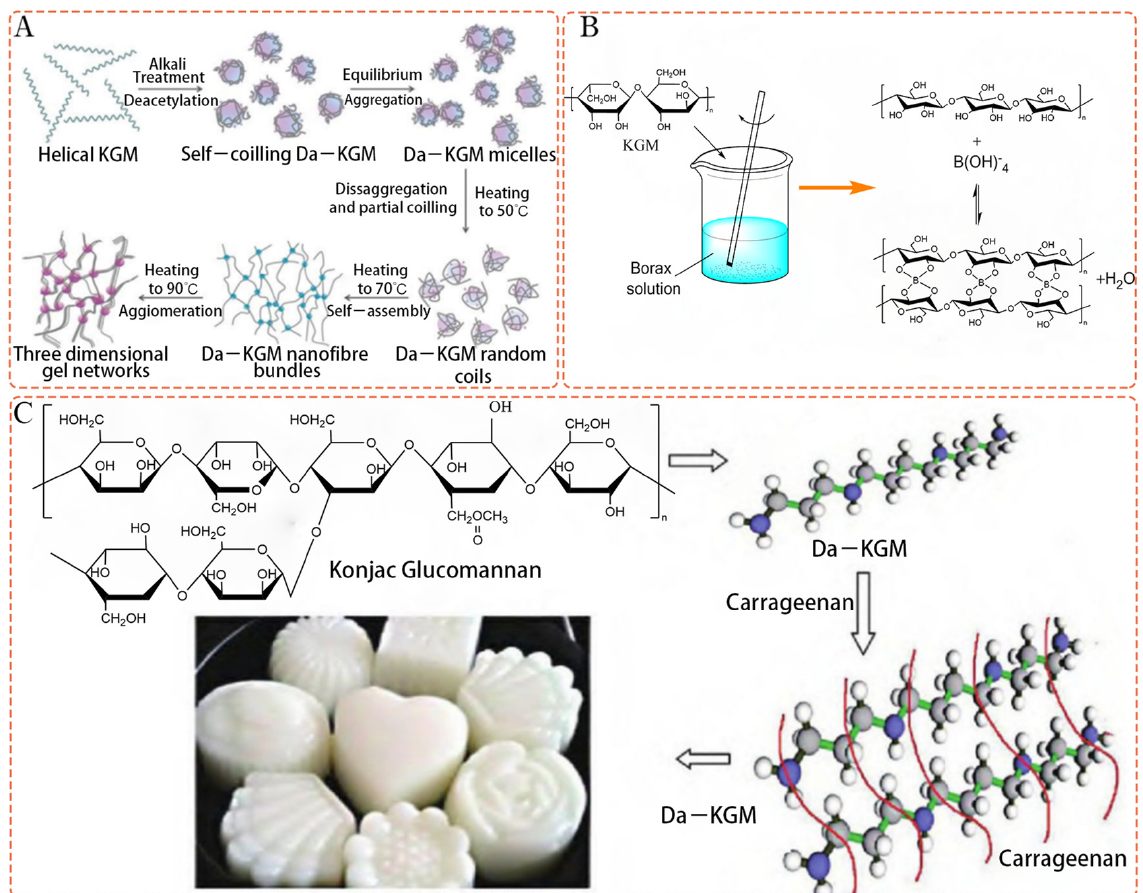
Figure 1. ( A ) Alkali–induced gelation mechanism of KGM (Adapted with permission from Ref. [6]. 2023, Elsevier); ( B ) Schematic diagram of the formation mechanism of KGM–borax hydrogel (Adapted with permission from Ref. [62]. 2023, Springer nature); ( C ) Schematic diagram of a gel of KGM with carrageenan (Adapted with permission from Ref. [65]. 2023, Elsevier).